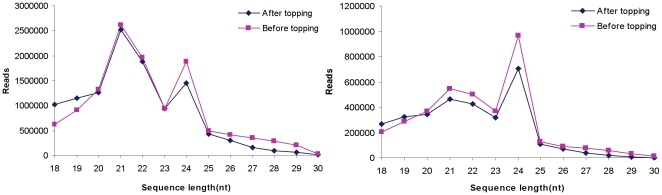
Size distribution of small RNAs in tobacco roots.Left: redundant reads; Right: unique reads.